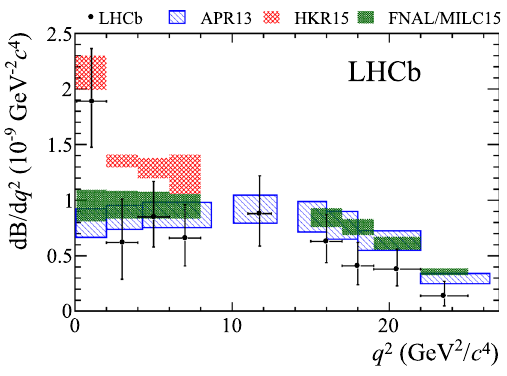
Fig. 1 Differential branching fraction of the B − → μ + μ − π − decay as a function of q 2 = m 2 (μ + μ − ) , taken from Ref. [30]. The hashed regions correspond to theoretical predictions from Refs.